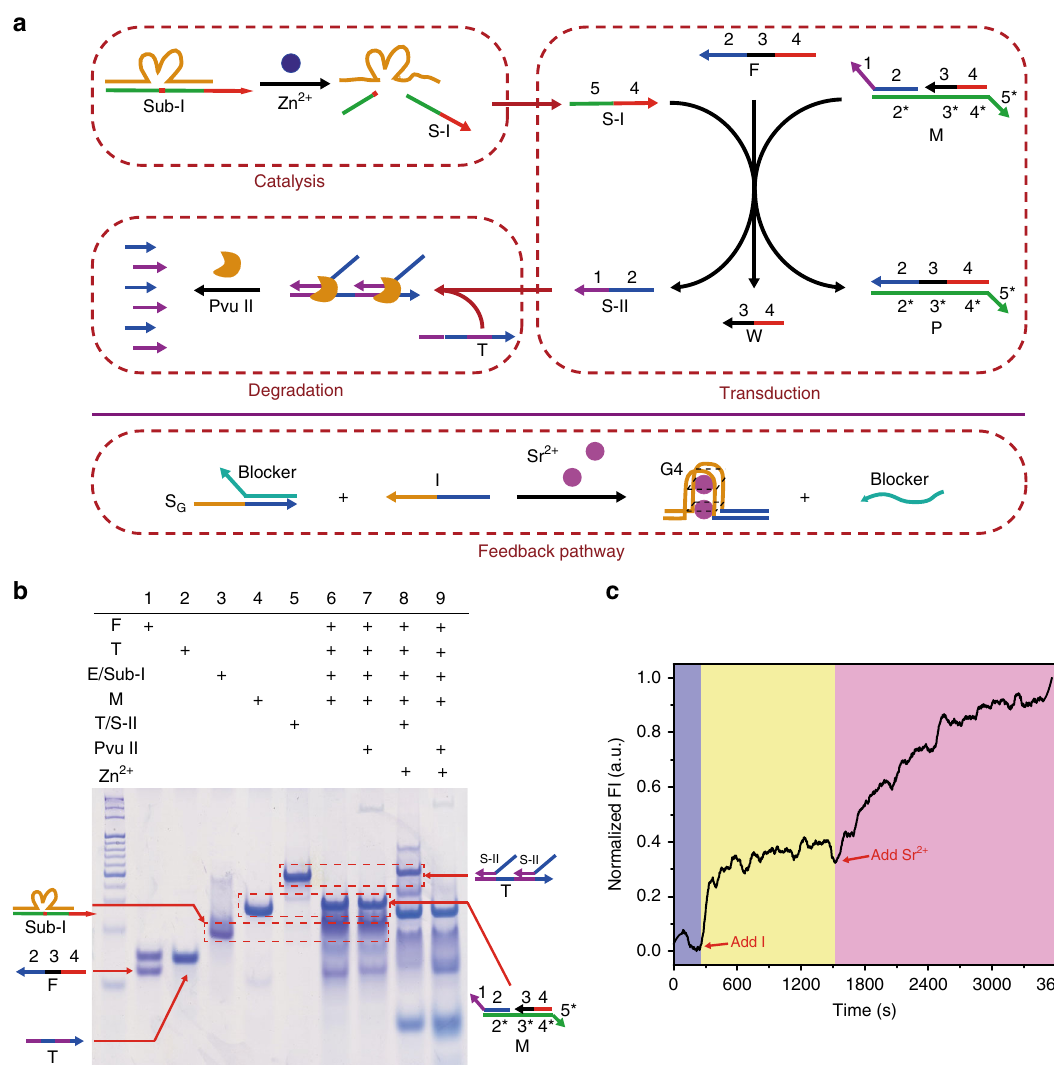
Fig. 4 Construction of an arti fi cial molecular signaling network. a Schematic representation of signaling network downstream modules and feedback module. Red dashed box indicates each con fi ned reaction module. b Twelve percent PAGE analysis of signaling network modules, including ion-mediated catalytic reaction, a DNA circuit reaction and protein enzyme-assisted DNA degradation. DNA cascade reactions were performed in a 37 °C water bath. Lane 1: F strand; Lane 2: T strand; Lane 3: Hybrids of E and Sub-I (E/Sub-I); Lane 4: M strand; Lane 5: Hybrids of T and S-II (T/S-II); Lane 6: Former four DNA reagents; Lane 7: Sample in lane 6 treated with Pvu II; Lane 8: Samples of lane 6 adding zinc ion; Lane 9: Samples of lane 6 treated with Pvu II and zinc ion. Plus ( “ + ” ) mark indicates the presence of the corresponding molecule. c Fluorescence kinetics showing the dynamic DNA strand displacement of feedback pathway. As shown by the red arrow, the 20 nM strand I and 10 mM Sr 2 + were successively added into the 20 nM S G R duplex solution. Source data are provided in the Source Data fi